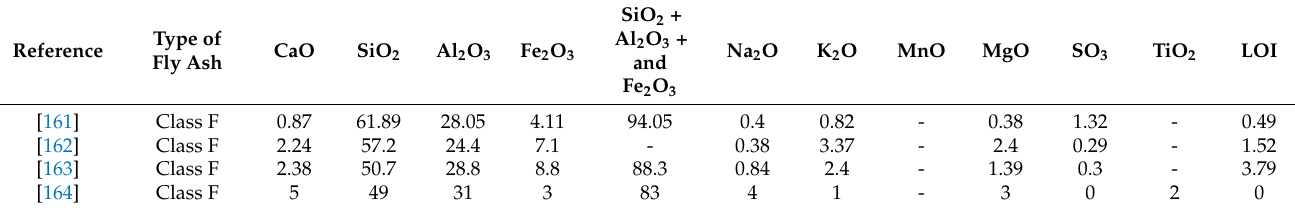
Table 1. The chemical composition of fly ash in previous